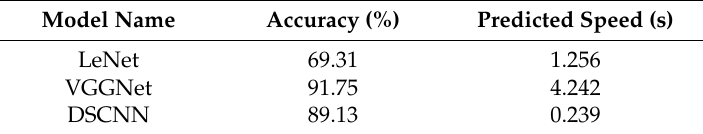
Table 1. Comparison of recognition accuracy and predicted